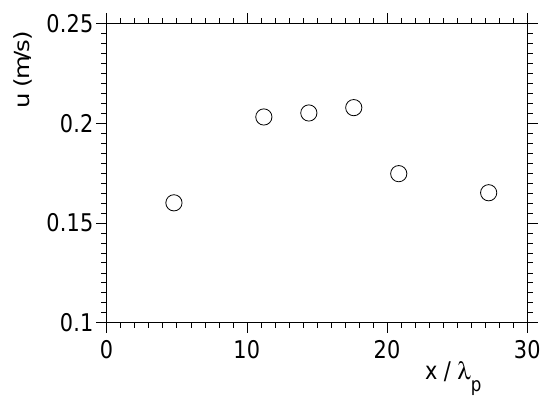
Fig. 2. Current velocity along the mean wave direction.